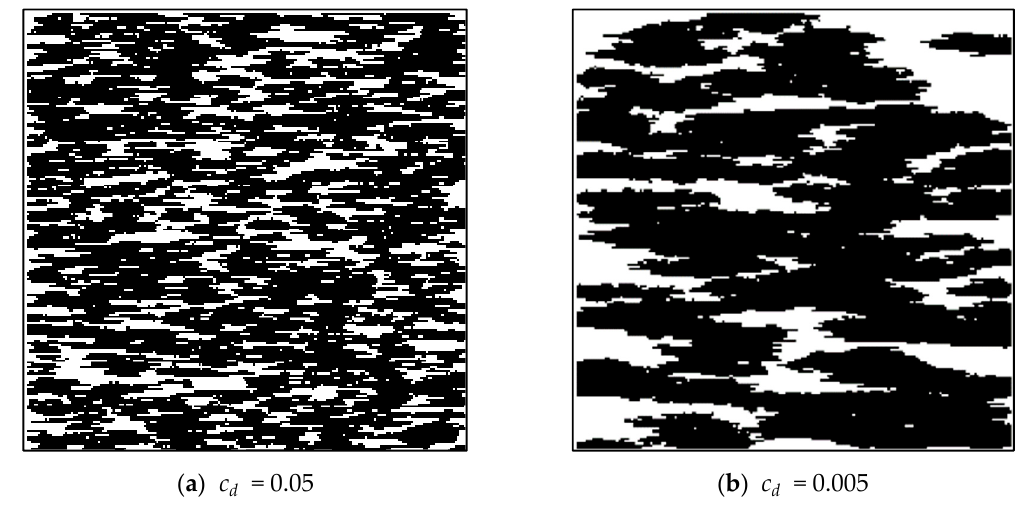
Figure 28. Quartet structure generation set with different growth core probabilities.